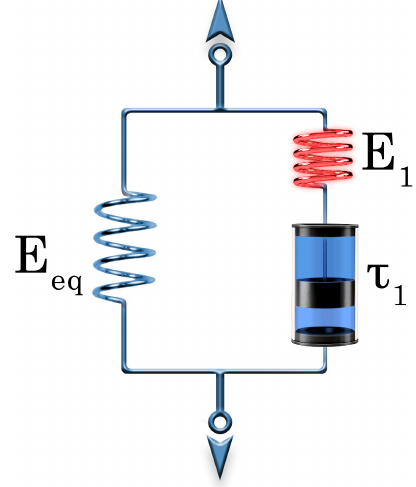
Figure 9. The Standard Linear Solid (SLS) viscoelastic model (also known as Zener model). E eq and E 1 is the Young’s modulus of the spring in the equilibrium and in the non-equilibrium branch, respectively, while τ represents the stress relaxation time in the non-equilibrium branch as τ = η / E 1 , where η is the viscosity of the liquid.